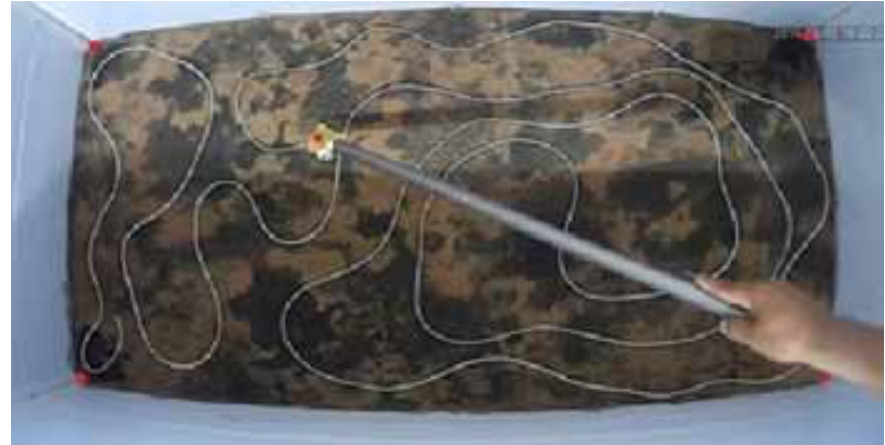
Figure 1 . Enriched environment, with the nylon line of 10 meters distributed randomly in the background, markings of the extremities (calibration points in red) and the rod with the mini-bag marked with the